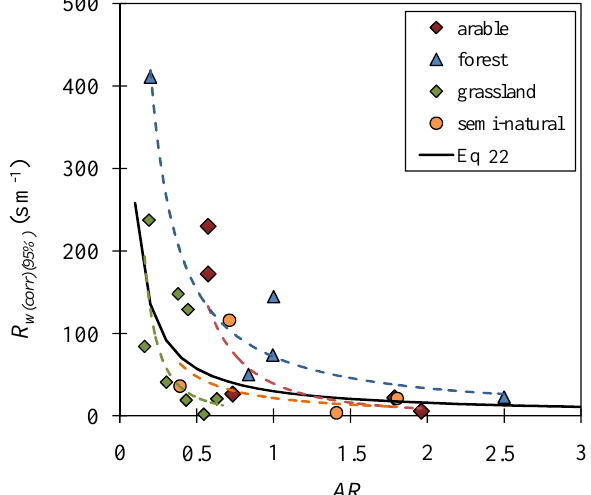
Fig. 7. Cuticular resistance at 95% relative humidity ( R w ( corr )( 95% ) ) as a function of the ratio of total acid/NH 3 (AR)=(2[SO] 2 +[HNO − ]+[HCl])/[NH 3 ] in the atmosphere separated according to ecosystem type. R w ( corr )( 95% ) is cor- 3 rected for LAI and temperature. Dotted lines represent the corresponding fitted power curves to the data by ecosystem type. The solid line represents the fitted power curve to all ecosystem